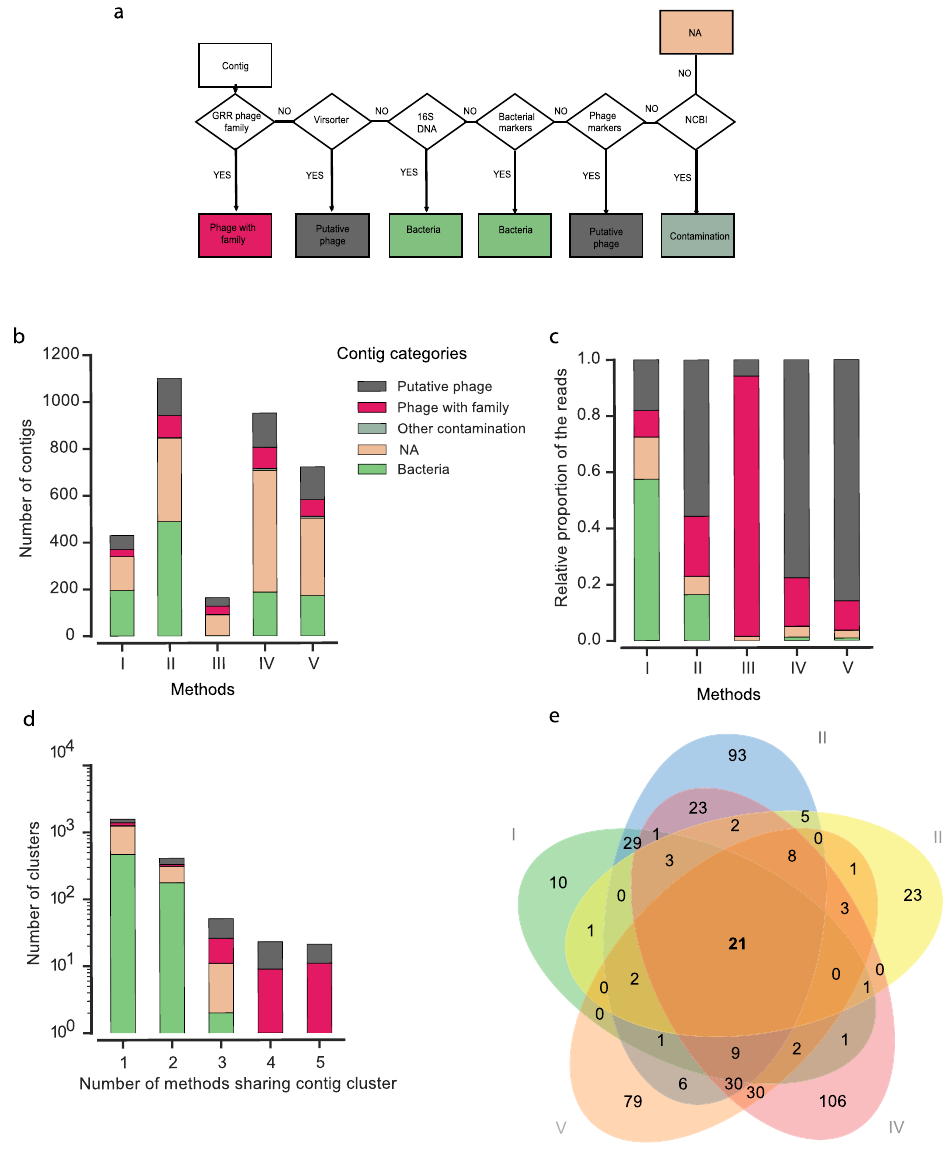
Figure 1. Algorithm to explore contigs and comparison between the five different phage isolation methods (I to V) used to analyse the faeces sample AA 0 of the volunteer AA. ( a ) Flowchart for the taxonomic attribution of the contigs with a complete method. It permitted to classify a contig according to the following groups: “phage with family”, “putative phage”, “bacteria”, “contamination”, “non-attributable (NA)” according to wGRR strategy, Virsorter software, HMM bacterial markers and 16S profile and NCBI database. ( b ) Number of contigs with a minimum of three ORFs, after a rarefaction step, classified following the procedure in ( a ). ( c ) Frequency of reads mapping the different classes of contigs. ( d ) Number of methods sharing contig clusters. For example, 21 contig clusters (all categorized as phage) were retrieved by all the methods. ( e ) Venn diagram of the number of phage clusters identified for each method (only clusters where the referenced sequence is classified as “phage with family” and “putative phage”). NA: